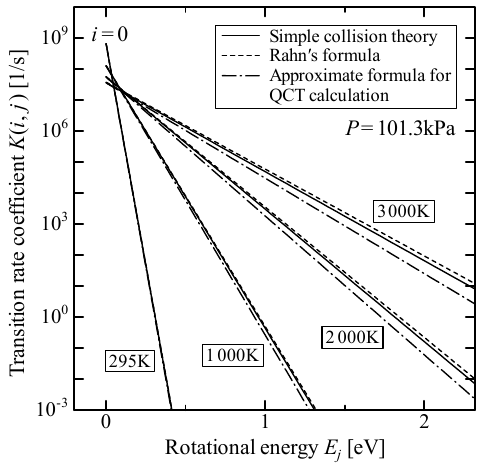
Fig. 2 Transition rate